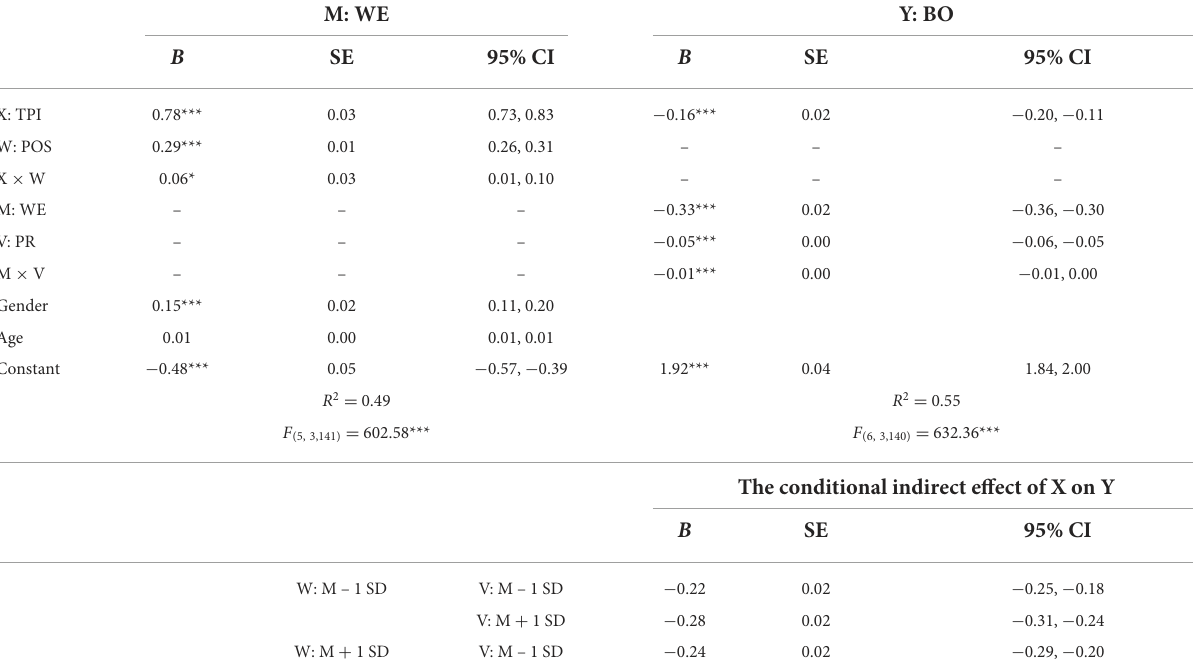
TABLE 3 Results of the moderated mediation